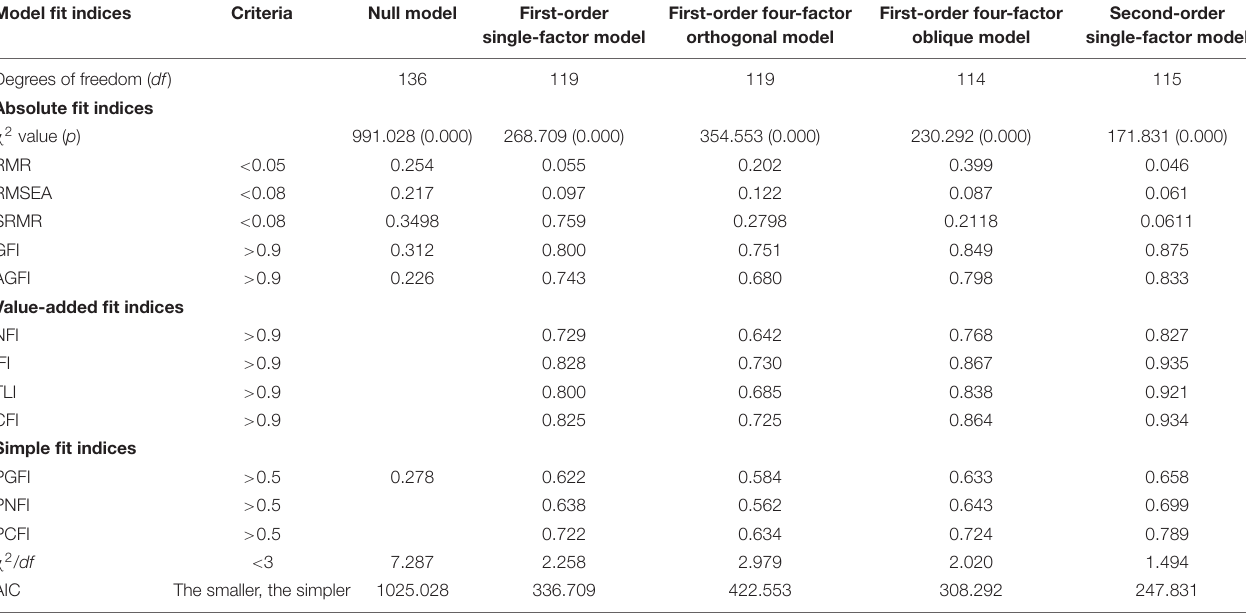
TABLE 3 | The fit indices of competing models of the Technology Product Imagination Disposition